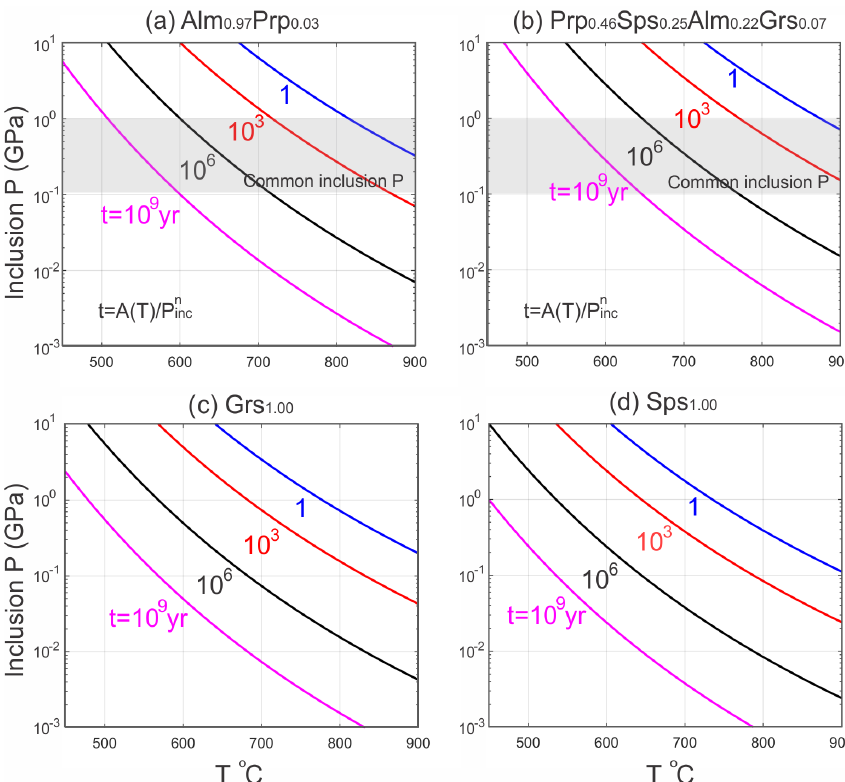
Figure 3. Viscous relaxation time (in years) of different garnet hosts as functions of temperature and inclusion overpressure. The viscous relaxation time is calculated based on the expression of the Deborah number ( De = 1) in Eq. (19). The viscosity’s pre-factor is T -dependent and is obtained using the flow law from Wang and Ji (1999). The melting temperature is from Karato et al. (1995) (the melting temperature of almost pure almandine is taken from the data of Mohawk Garnet Inc. to be 1588K). Shear modulus is from Bass (1995). The flow law is given in the main text (Wang and Ji, 1999). The four garnet endmembers are almandine (Alm), grossular (Grs), pyrope (Prp), and spessartine